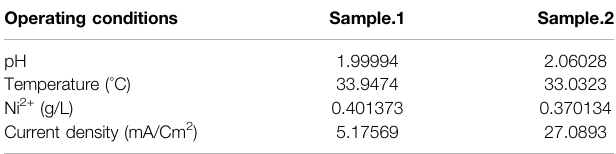
TABLE 4 | Proposed optimum condition by GA.